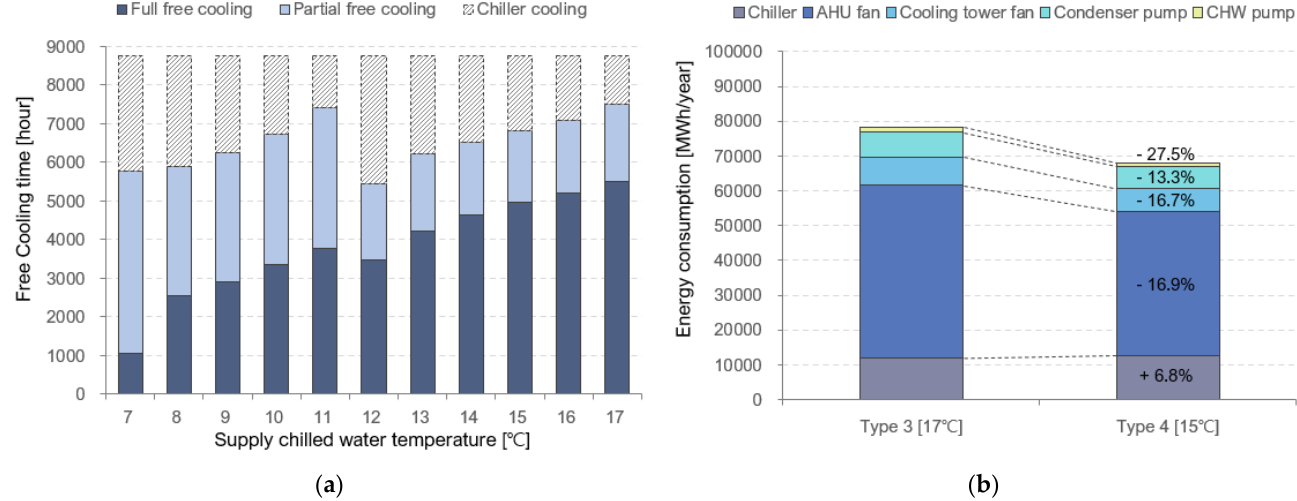
Figure 9. Free cooling time for type 3 and energy reduction for type 3 with respect to the optimal chilled water set temperature for type 2. ( a ) Type 4 free cooling time, ( b ) energy saving for type 4 (17 °C) compared to type 3 (11 °C).